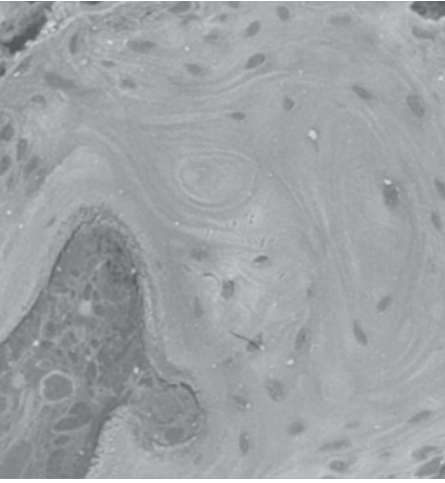
Figure 3b. Detail of Fig. 3a showing the remodelling in mature